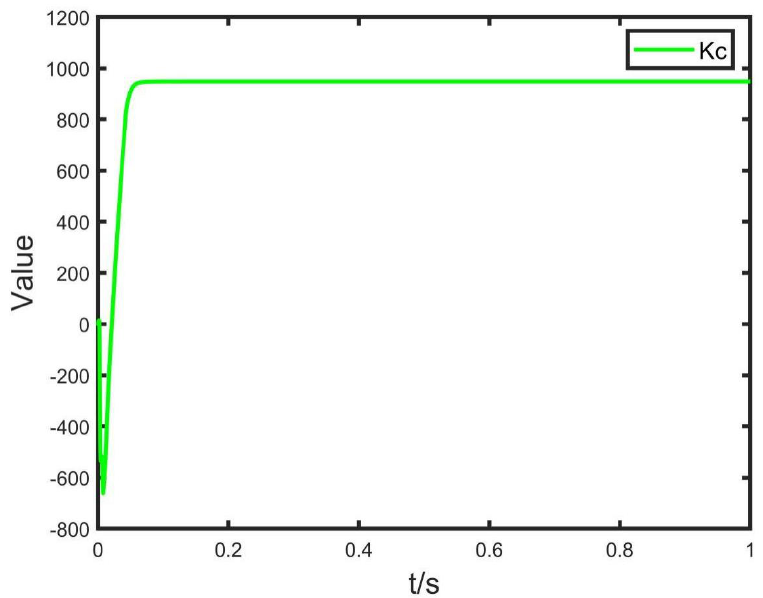
Figure 6. Adaptive adjustment curve of c k .